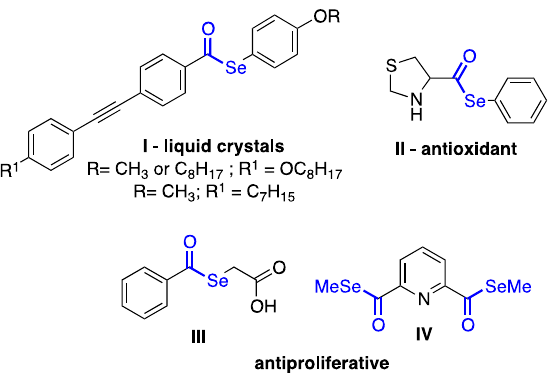
Figure 1. Examples of molecules bearing the selenol ester moiety.